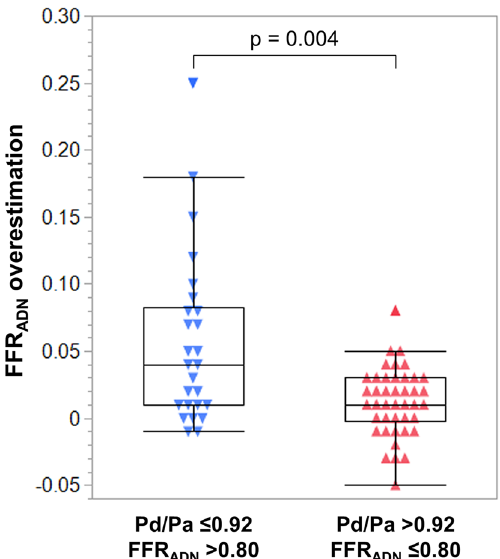
Figure 3. Comparison of FFR ADN overestimation between low Pd/Pa–high FFR ADN and high Pd/Pa–low FFR ADN groups. Distributions of FFR ADN overestimation with box-and-whisker plots are shown. FFR ADN overestimation was defined as FFR ADN – FFR PAP . FFR ADN fractional flow reserve value associated with adenosine, FFR PAP fractional flow reserve value associated with papaverine, Pd/Pa distal-to-aortic pressure